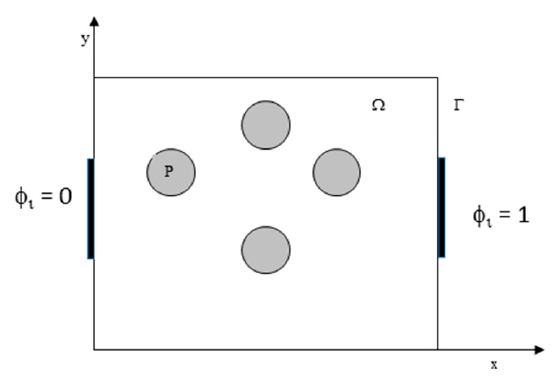
Figure 1. A typical rectangular prism shaped domain used in our simulations. The fluid velocity on the domain walls is assumed to be zero and the electrode’s potential is specified.